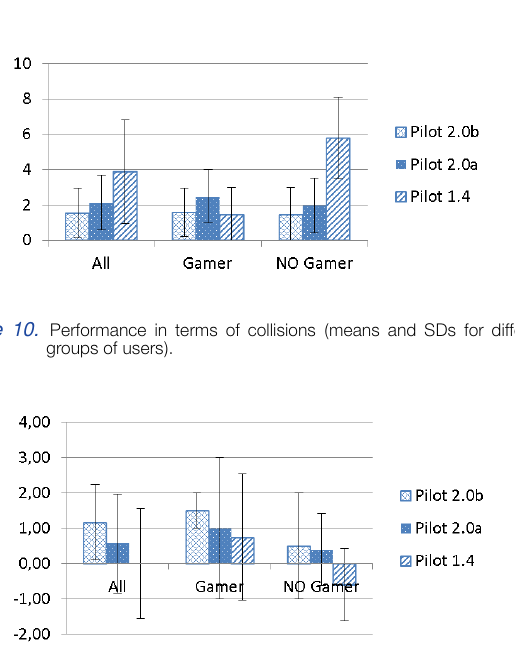
Figure 14. Pass through narrow